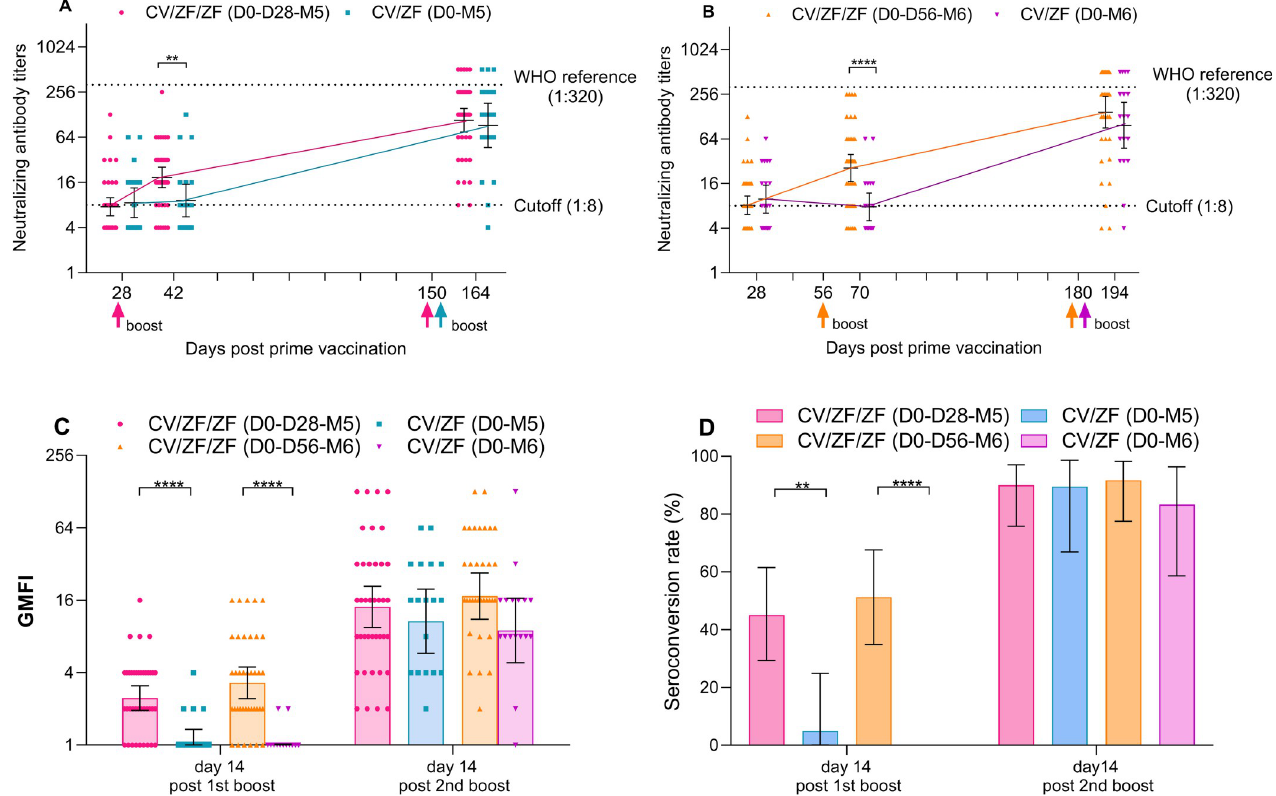
Fig 2. Neutralizing antibodies against wild-type SARS-CoV-2 after prime and boost dose. ( A and B ) GMTs of neutralizing antibodies to wild-type SARS-CoV-2 28 days after prime dose, 14 days after first and second boost dose ( C ) GMFI of neutralizing antibodies to wild-type SARS-CoV-2 14 days after first and second boost, compared to baseline (28 days post prime). ( D ) Seroconversion rate (%) of neutralizing antibodies to wild-type SARS-CoV-2 14 days after first and second boost. Seroconversion was defined as at least a 4-fold increase in the antibody titers at different time points after boost compared to baseline (28 days post prime). The WHO reference (1,000IU/ ml) is equivalent to a neutralizing antibody titer of 1:320 against wild-type SARS-CoV-2. Cutoff (1:8) refers to the detection limit. Up arrow represents the boost immunization. Horizontal bars show geometric mean or mean and error bars show 95% CI. �� P < 0.05, ���� P < 0.001. CV/ZF/ZF (D0-D28-M5) = receiving Convidecia/ZF2001/ZF2001 at day 0, day 28, and month 5; CV/ZF (D0-M5) = receiving Convidecia/ZF2001 at day 0 and month 5; CV/ZF/ZF (D0-D56-M6) = receiving Convidecia/ZF2001/ZF2001 at day 0, day 56, and month 6; CV/ZF (D0-M6) = receiving Convidecia/ZF2001 at day 0 and month 6. CI, confidence interval; GMFI, geometric mean fold increase; GMT, geometric mean titer; SARS-CoV-2, Severe Acute Respiratory Syndrome Coronavirus 2; WHO, World Health